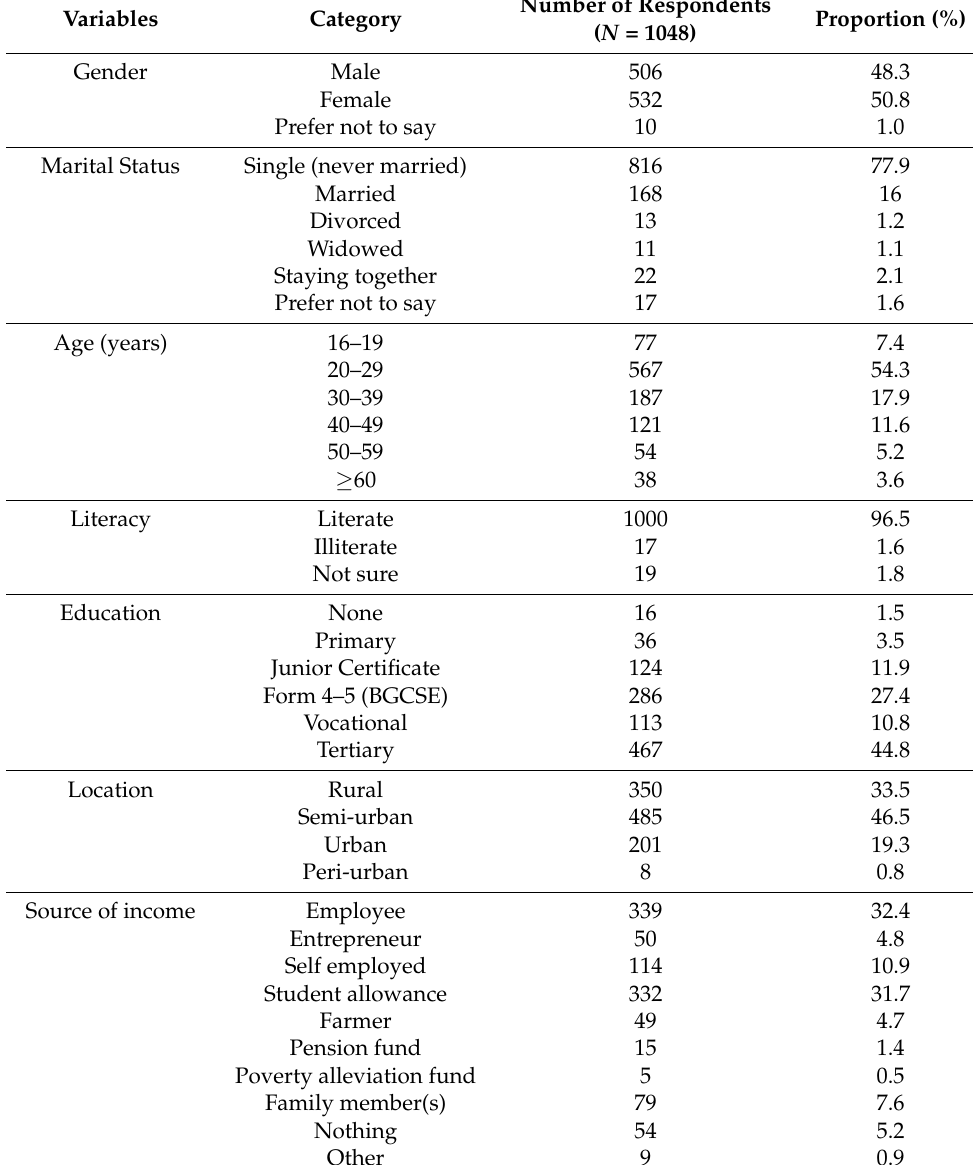
Table 1. A summary of results on the socio-demographic characteristics of respondents across the ten major districts of Botswana ( N = 1048). The valid percentage (i.e., whereby the total number of responses did not include the missing values) was used for the determination of reported